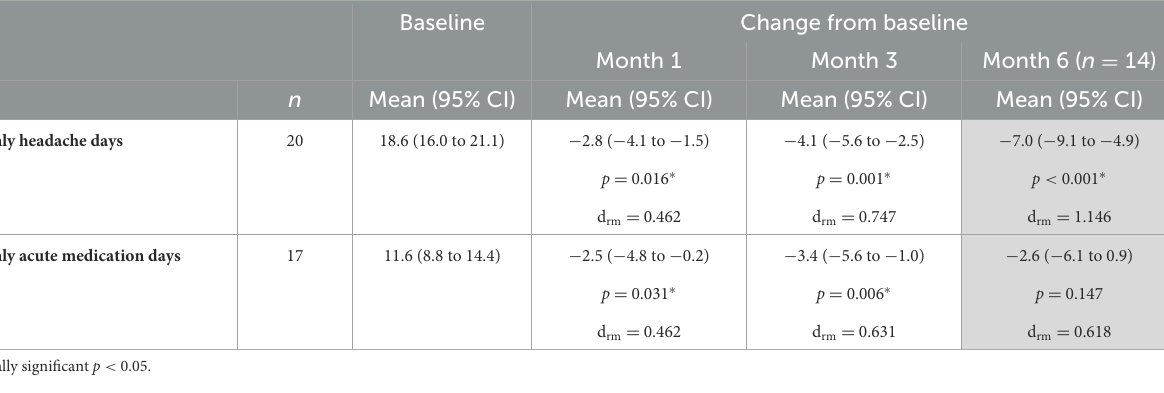
TABLE 3 Change of monthly headache days after switch to receptor antibody.